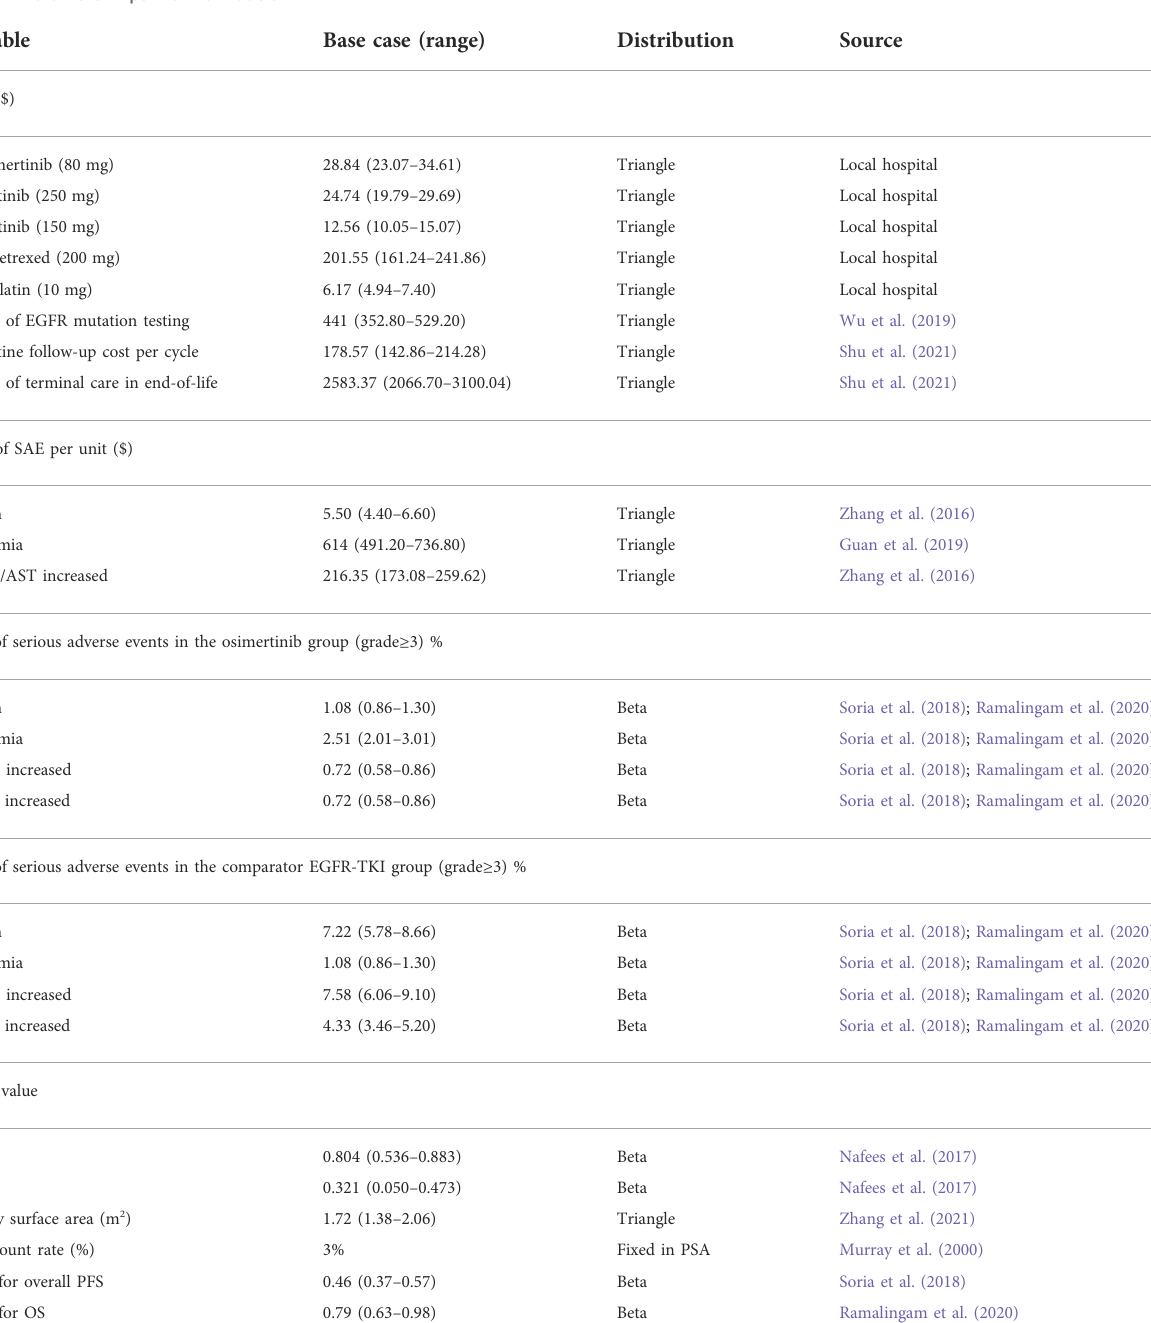
TABLE 2 Parameter input to the